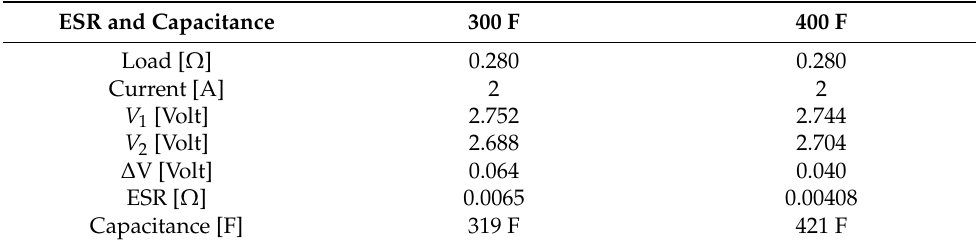
Table 4. Results for 300 F and 400 F from the discharge profiles.